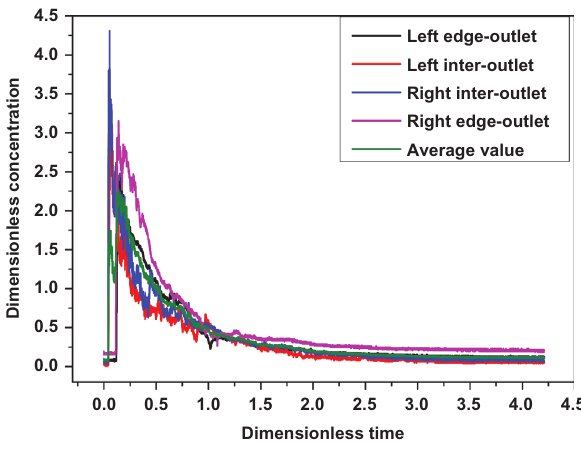
Figure 12: RTD curves in tundish with original porous baffle.